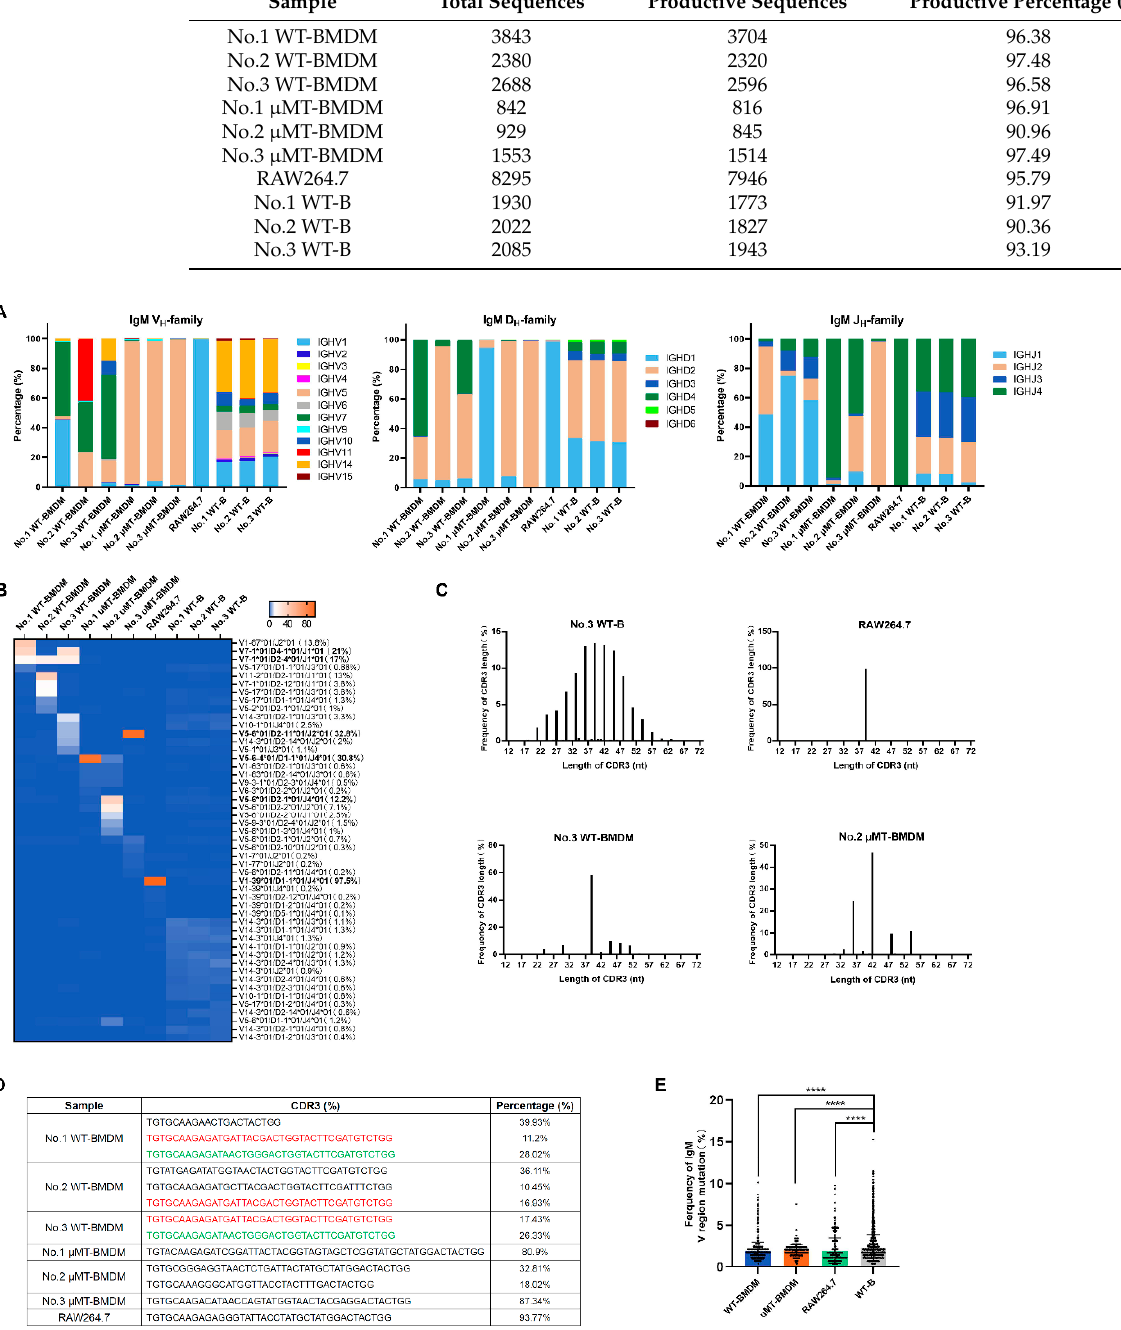
Table 2. The total number of V H DJ H recombination sequences and productive sequences were analyzed for each sample.